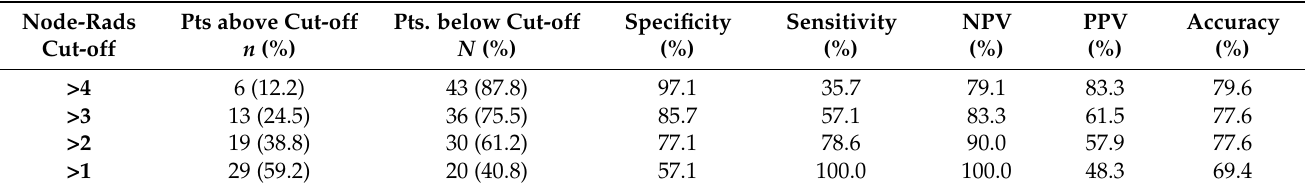
Table 2. Sensitivity, specificity, positive predictive value (PPV), negative predictive value (NPV), and accuracy were reported for the different Node-Rads